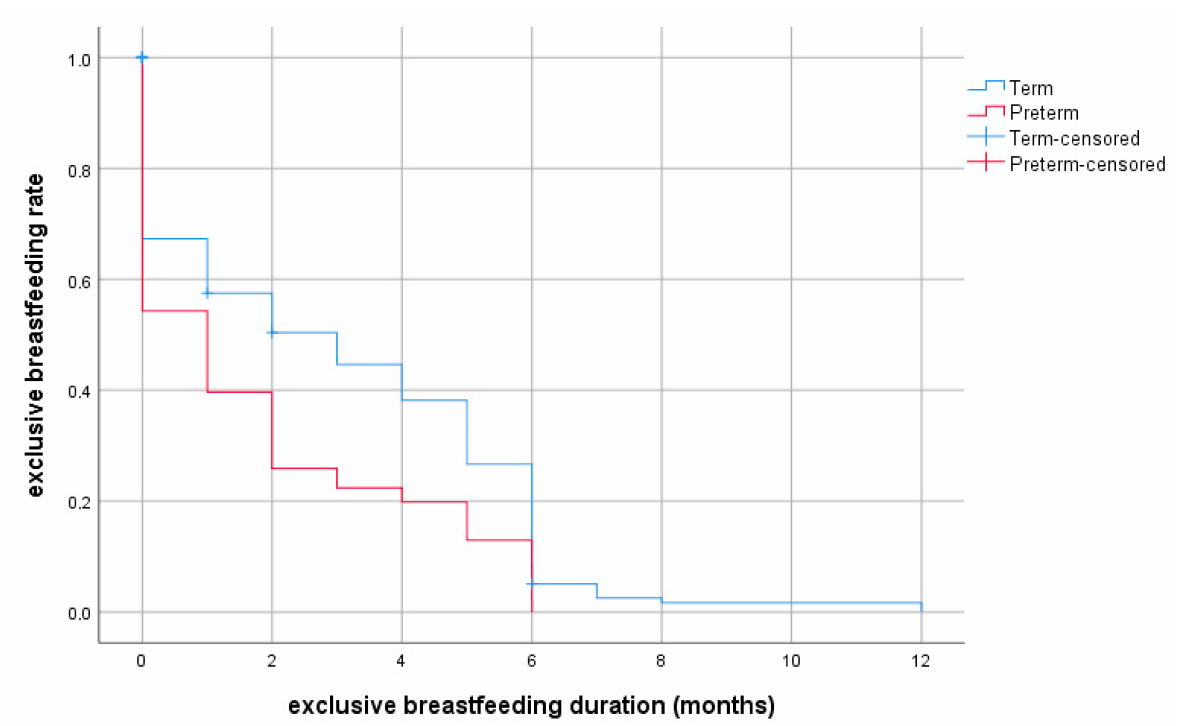
Figure 2. Probability of exclusive breastfeeding depending on duration (months, discrete survival curves) according to